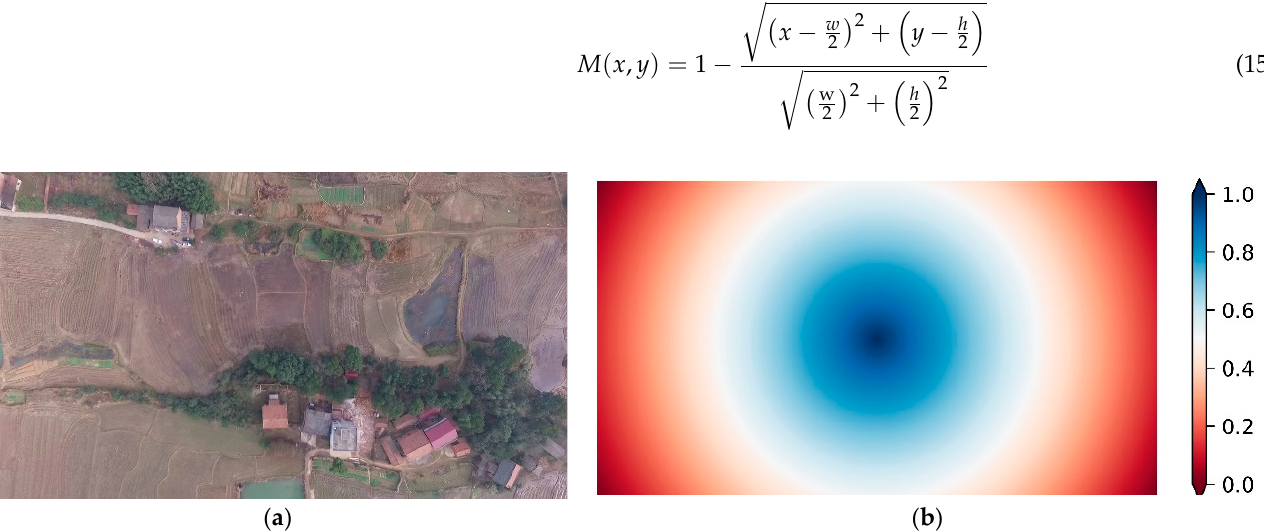
Figure 4. An image and its corresponding mask. ( a ) Image. ( b ) The mask of this image. The value in the mask represents how close each pixel is to the center of the image.